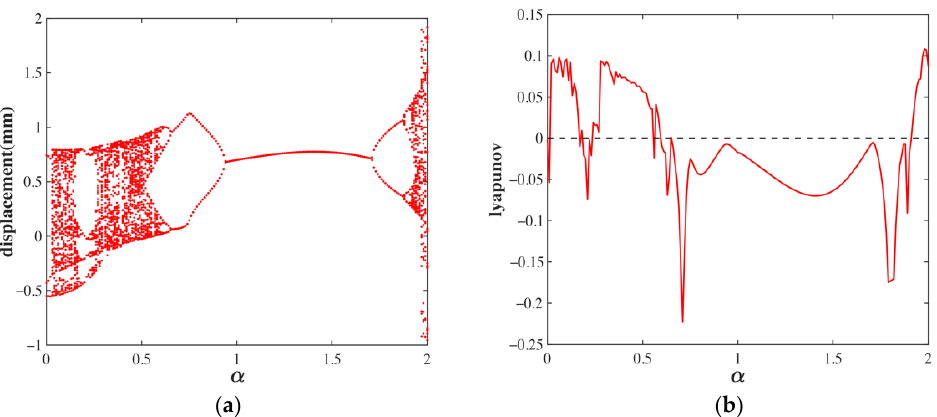
Figure 11. Bifurcation diagram and Lyapunov exponent diagram of the system when α varies: ( a ) Bifurcation diagram; ( b ) Lyapunov exponent diagram.